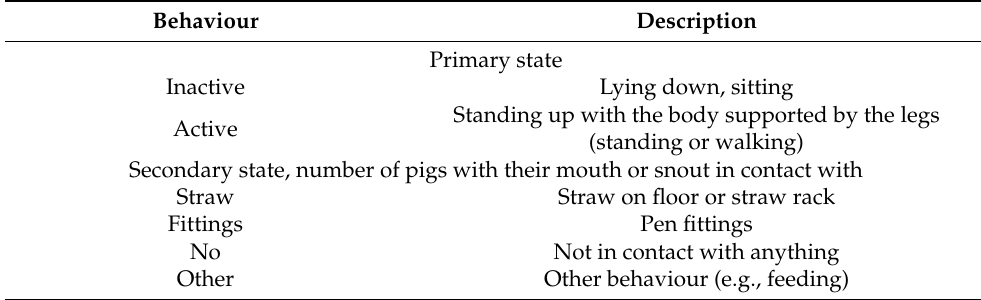
Table 1. Ethogram modified from Pedersen, Herskin